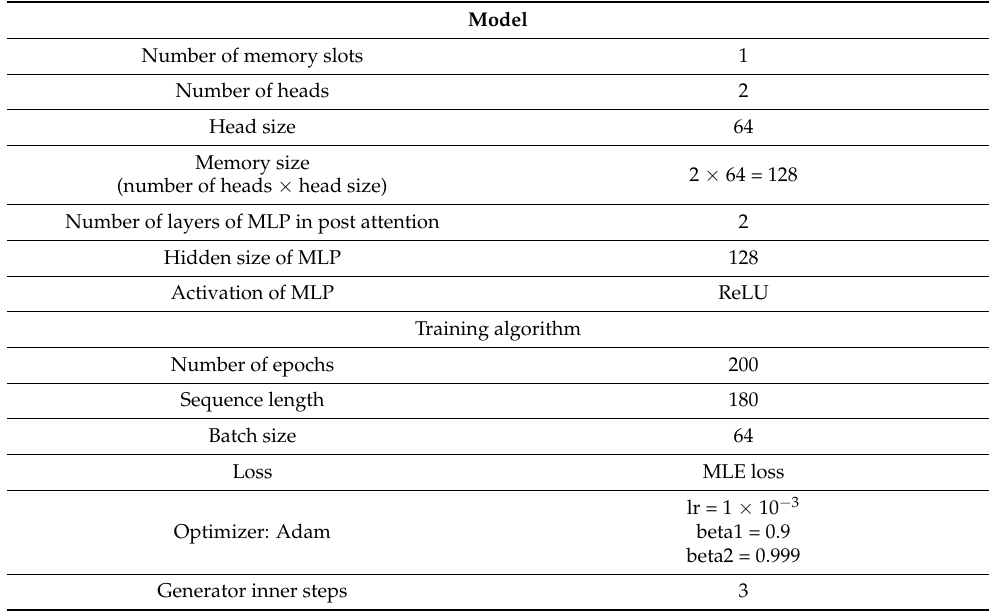
Table 2. Hyperparameters of stage transition sequence